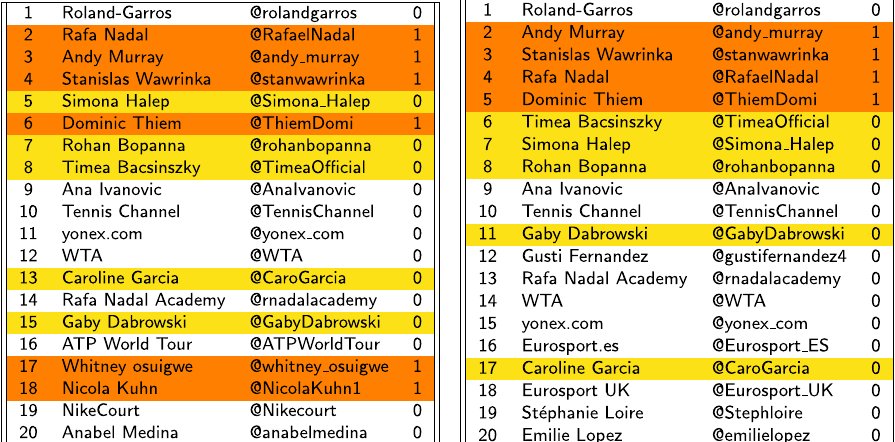
Table 5 Harmonic centrality (left) and decayed indegree (right) top list for RG17 semi final day (June 9) at 12:00